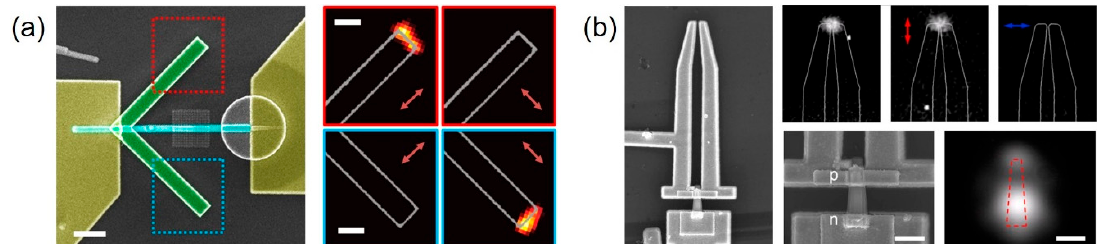
Figure 10. Injection plasmonic light source based on NW LEDs. ( a ) Electrically pumped NW light source coupled to plasmonic waveguides (left). Synthesized GaAs NW with axial p - n junction emits light that is coupled to plasmonic modes and re-emitted at the waveguide terminations (right) [42]. Figure reproduced with permission from American Chemical Society. ( b ) Top-down fabricated GaAs NW LEDs coupled to double-strip plasmonic waveguide that is gradually tapered at the end (left). Light coupled to plasmonic modes propagates through the waveguide and is focused into a sub-micron-sized light spot (right) [43]. Figure reproduced with permission from American Chemical